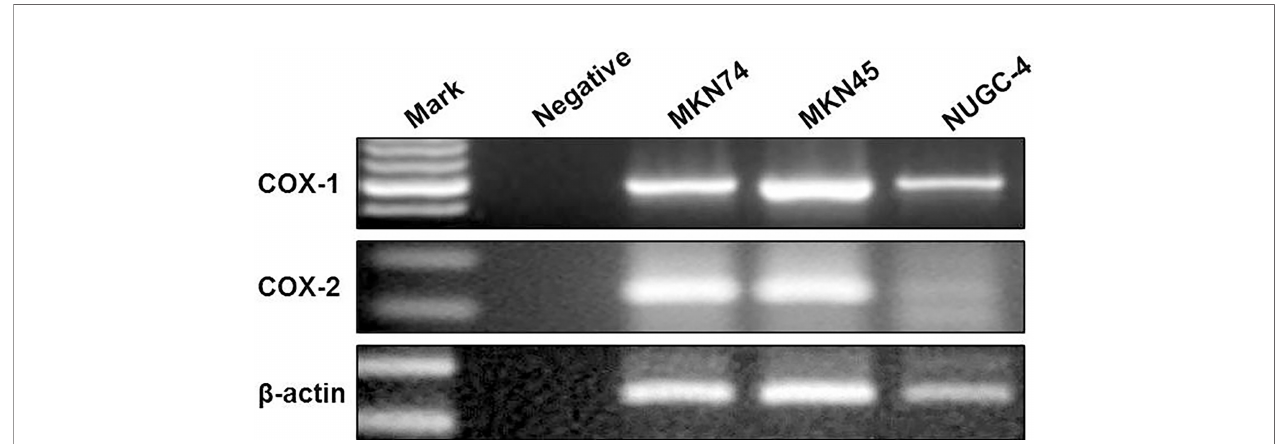
FIGURE 1 | The expression of COX-1 and COX-2 in gastric cancer cells. COX-1 and COX-2 mRNA in gastric cancer cell lines were measured by RT-PCR. PCR products stained with ethidium bromide were displayed at 1.5% agarose gel electrophoresis. b -Actin served as a loading control. The experiments were performed at least